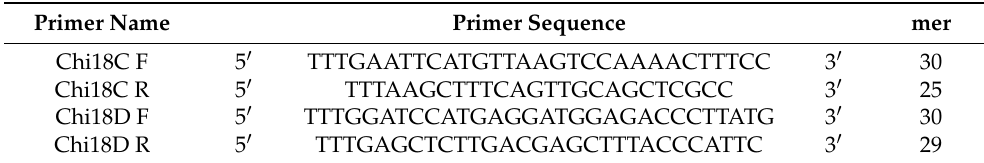
Table 4. Primers for pET expressions of Chi18C and